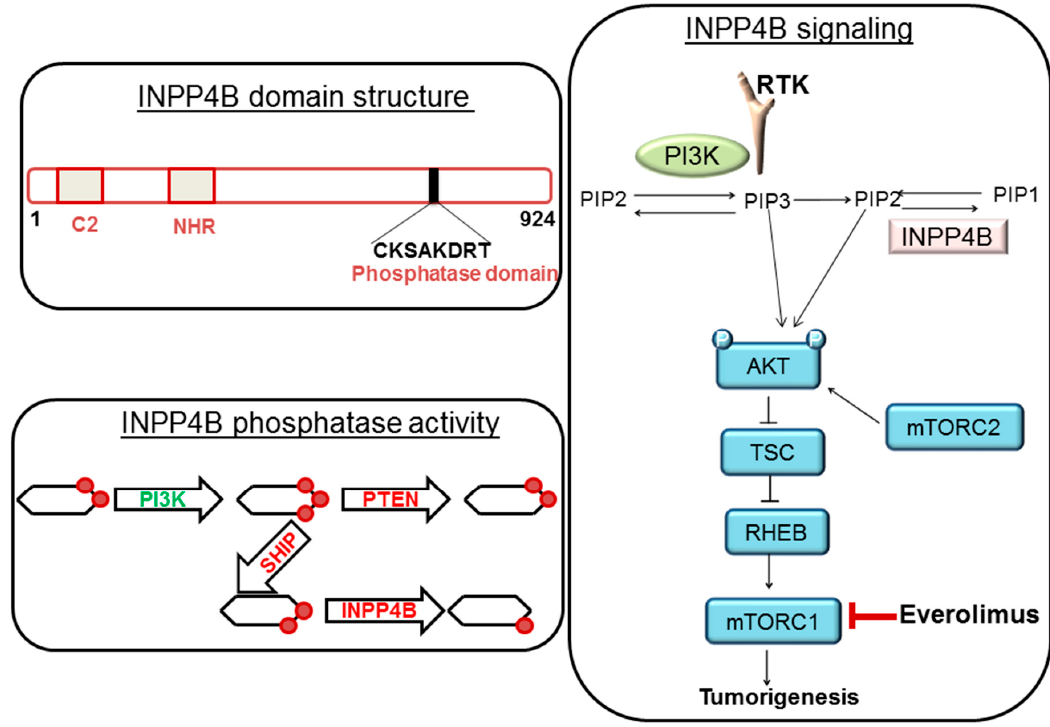
Figure 5. Domain structure, function, and signaling of INPP4B.